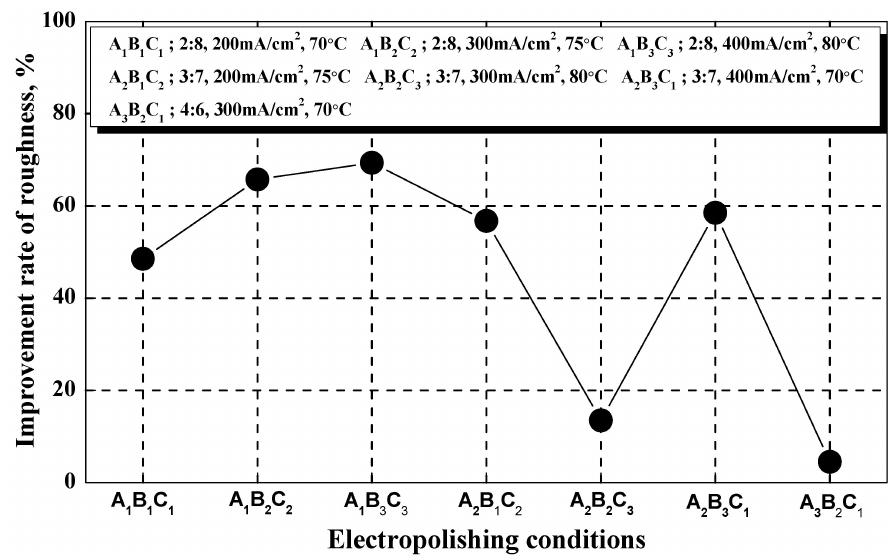
Figure 7. Comparison of surface roughness improvement rates after